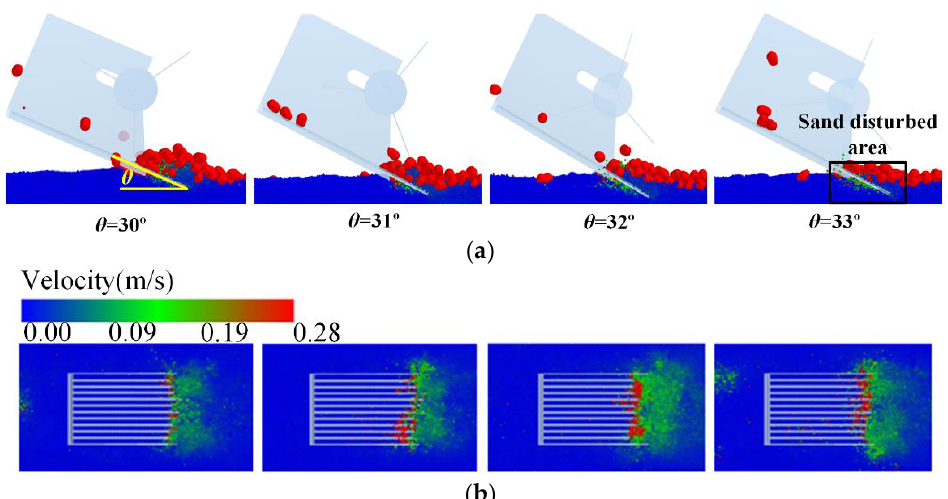
Figure 10. Schematic diagram of the basic conditions of jujubes and sandy soil under different ACTs. ( a ) Schematic diagram of the accumulation effect of jujubes and sandy soil under different ACTs. ( b ) Schematic diagram of the disturbance of sandy soil under different ACTs.